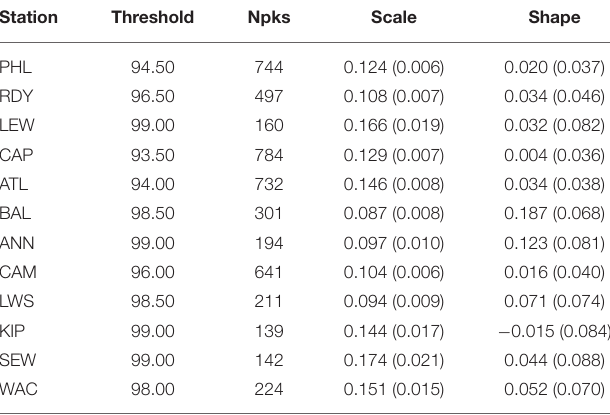
TABLE 4 | Results from GP distribution model fit of extreme skew surges for tide gauges in the Mid-Atlantic region. Station